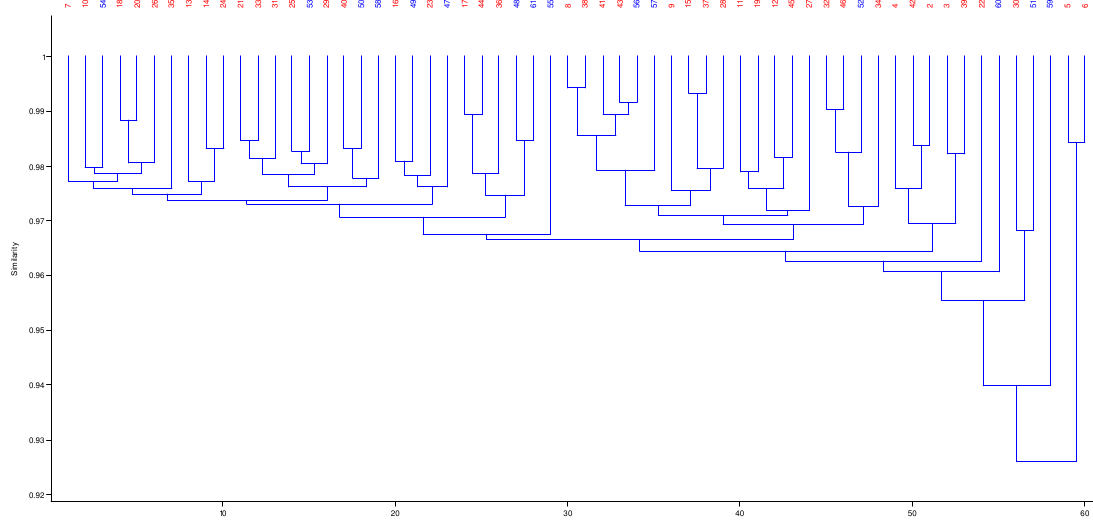
Fig. 5. Dendrogram showing similarity coefficient (92.6%) of the morphometrics of wild male and female Clarias gariepinus employing the Bray-Curtis’s clustering algorithm *Red color indicates male, blue color indicates female